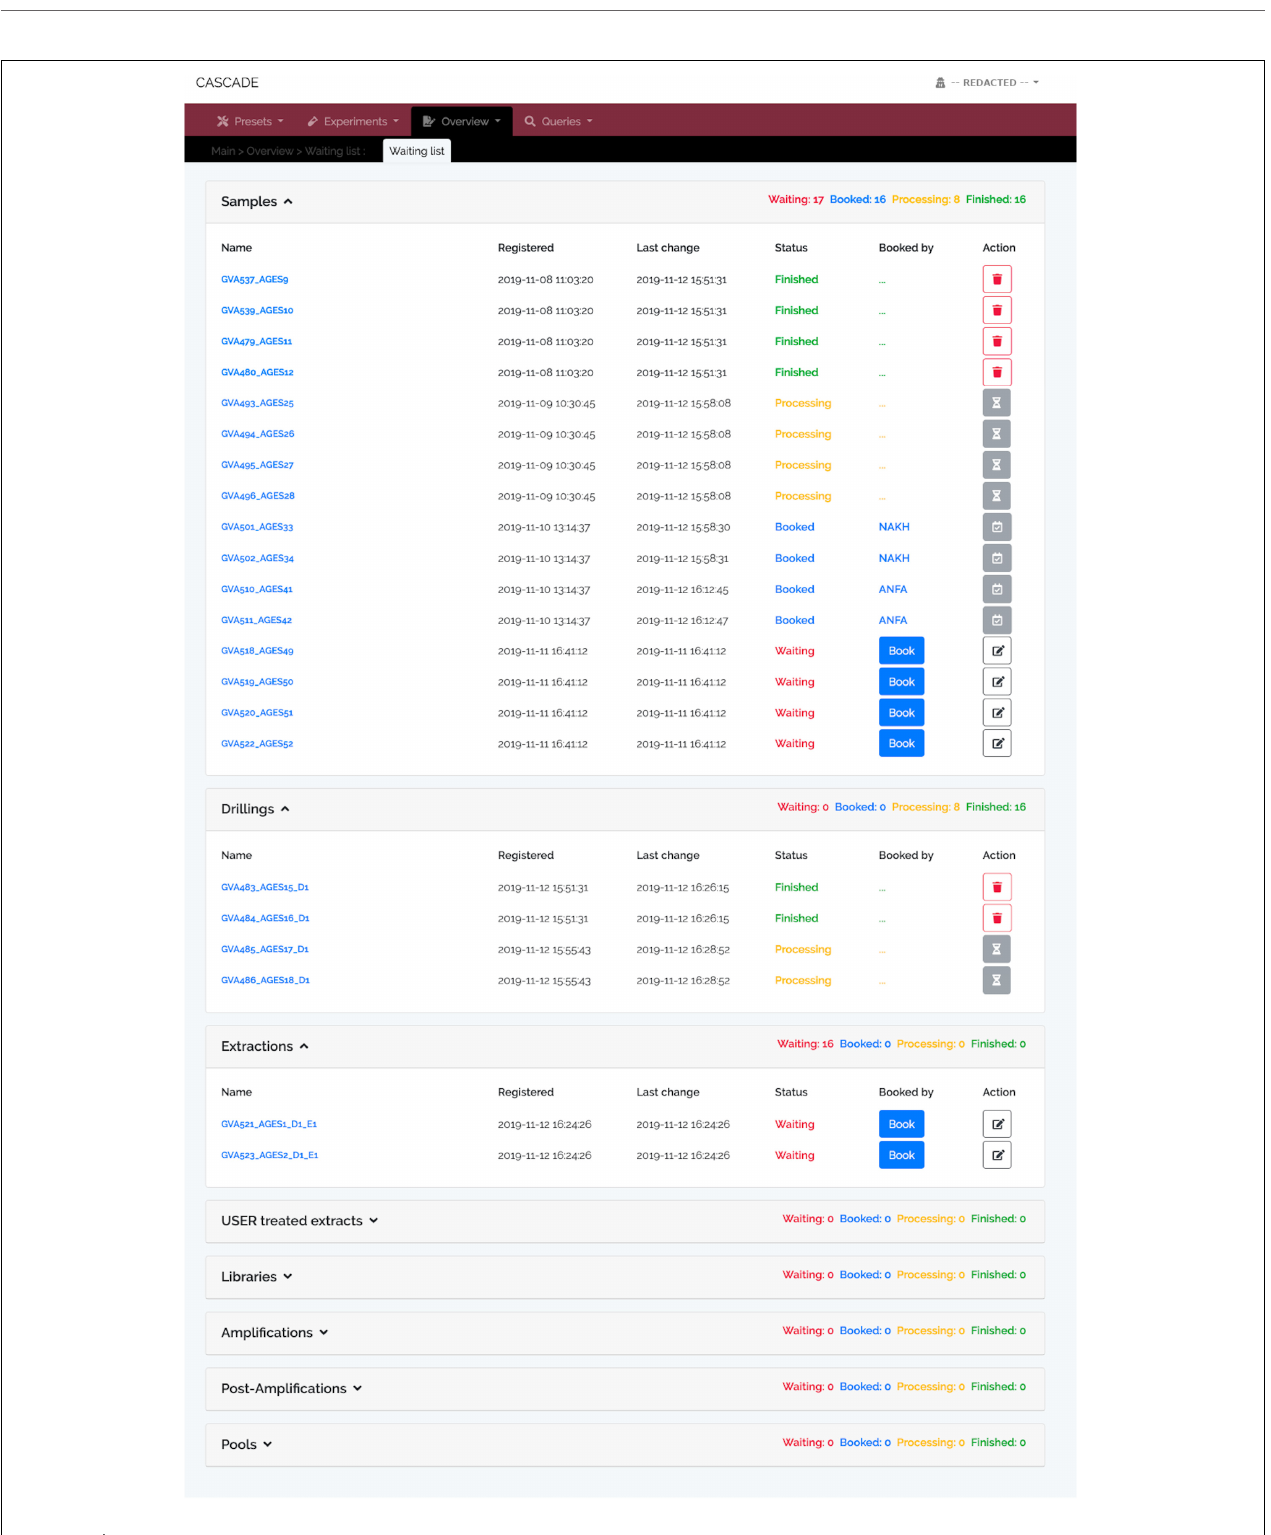
Frontiers in Ecology and Evolution |